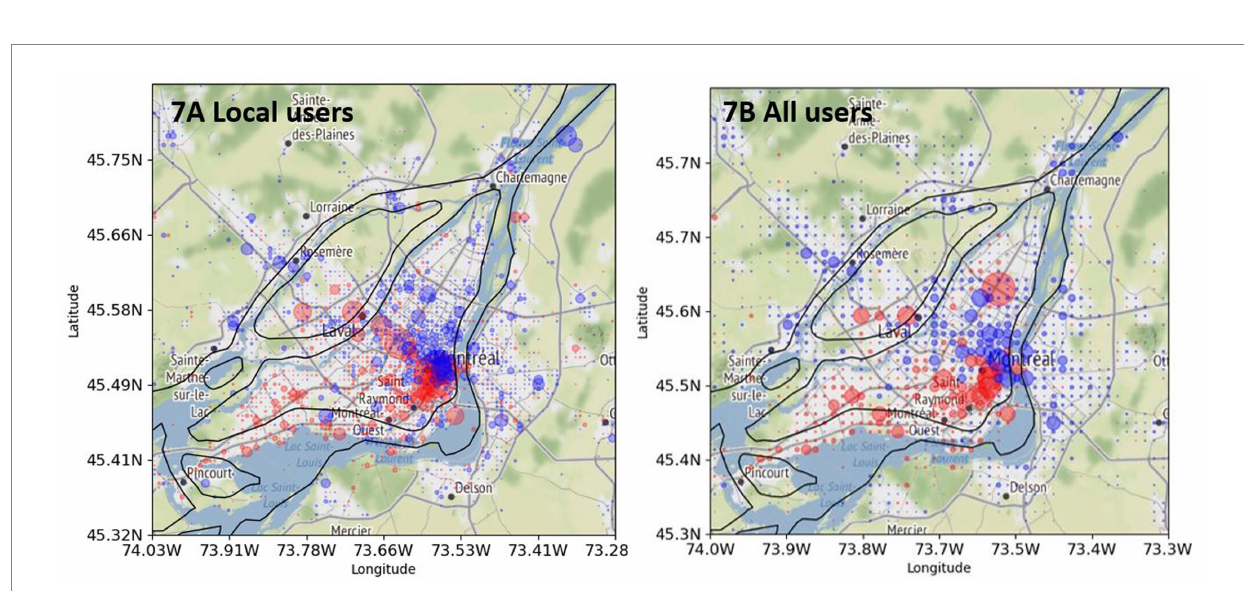
FIGURE 7 Comparison of English tweets (red) and French tweets (blue) posted by bilingual local and all users in Greater Montreal. ( A , left): “local” bilingual users (see also Figure 5B). ( B , right): “all” bilingual users. Base map and data from OpenStreetMap and OpenStreetMap Foundation under the Open Database